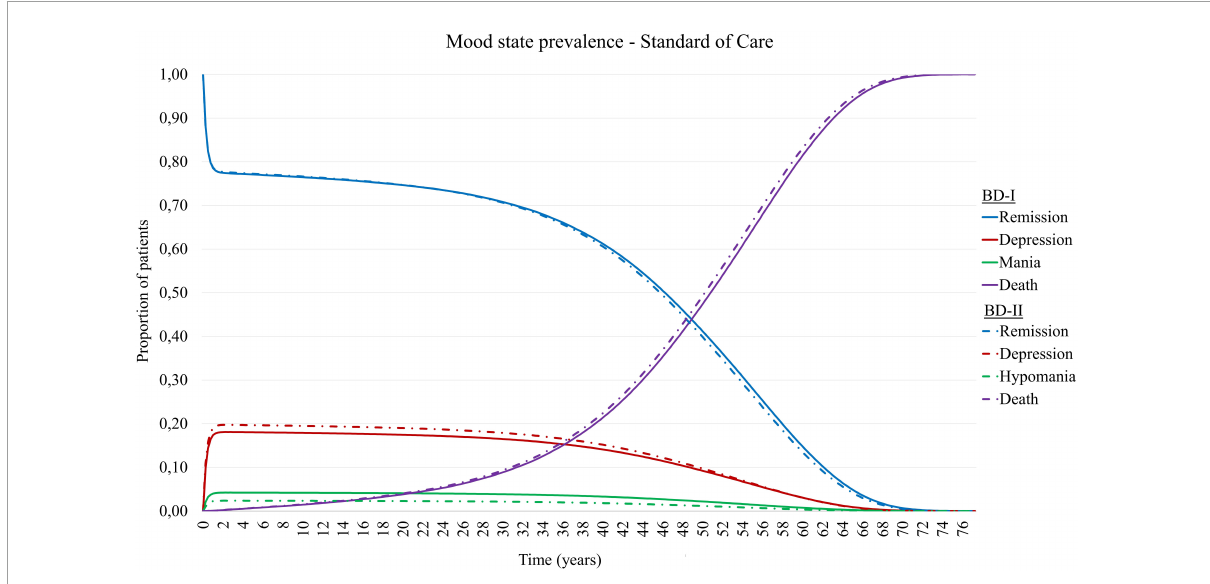
FIGURE2 Mood state prevalence of simulated patient cohort with Bipolar Disorder type I (BD-I) and type II (BD-II) in TiBipoMod, consisting of ∼ 4% of live patients in mania, ∼ 18% in depression, and ∼ 78% in remission.